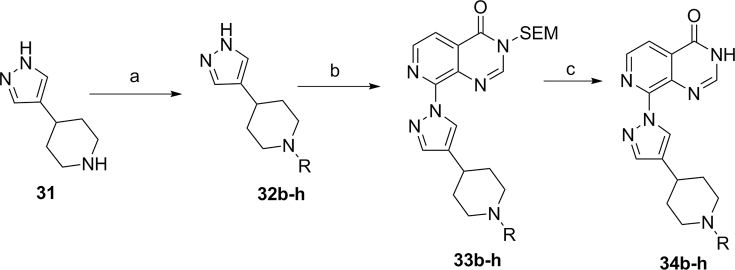
aReagents and conditions: (a) aldehyde, NaBH(OAc)3, DMF, room temp, stirring up to 6 h; (b) Cs2CO3, anhydrous MeCN, 8-chloro-3-((2-(trimethylsilyl)ethoxy)methyl)pyrido[3,4-d]pyrimidin-4(3H)-one, reflux, 18 h; (c) 6 M HCl, THF, 50–60 °C, 3–8 h.